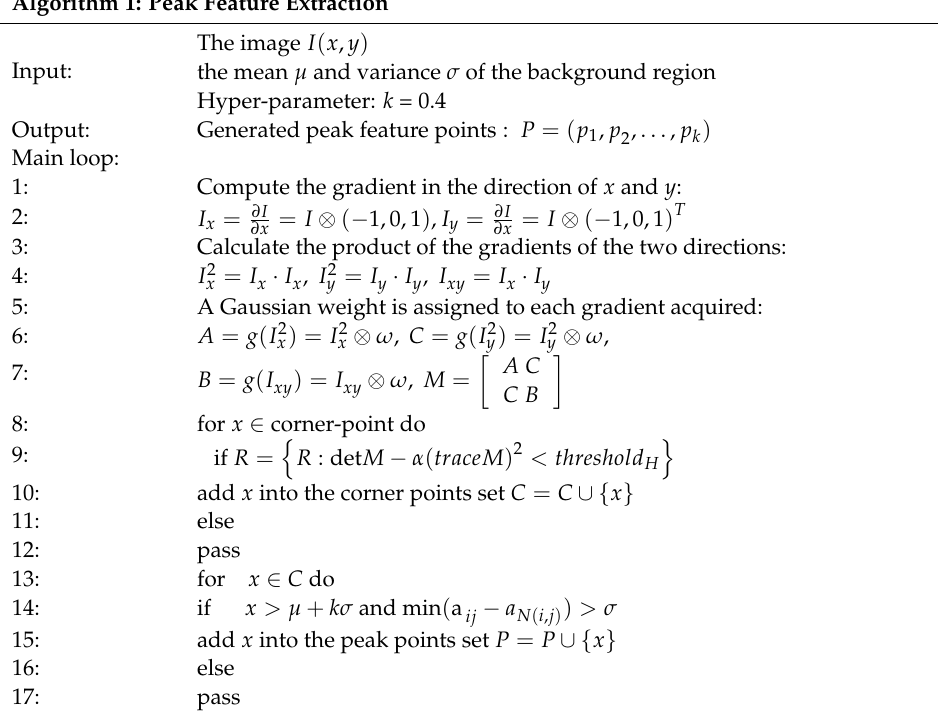
Algorithm 1: Peak Feature